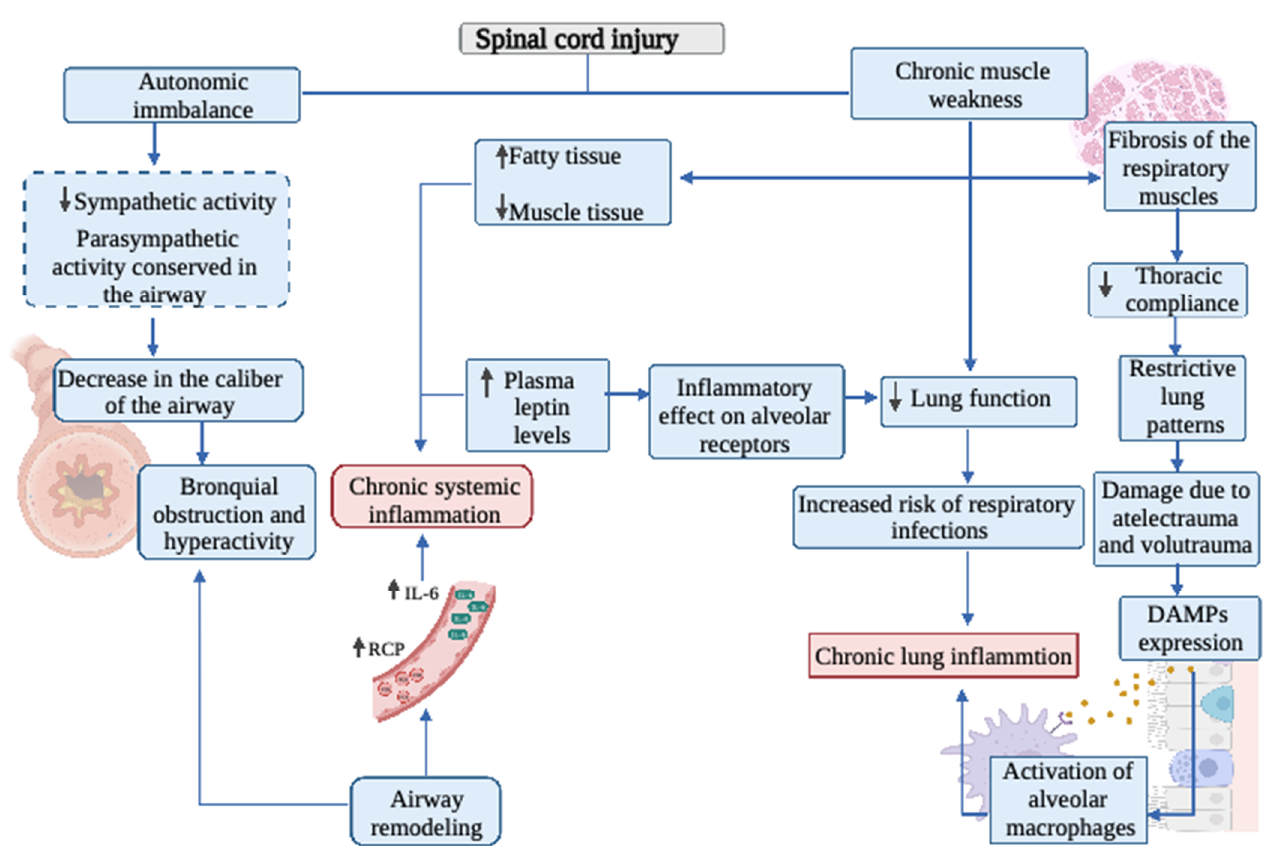
Figure 1. Overview of the role of inflammation and oxidative stress on the respiratory system in spinal cord injured patients. IL-6: Interleukin-6; CRP: C-reactive protein; DAMPs: Damage-associated molecular patterns.